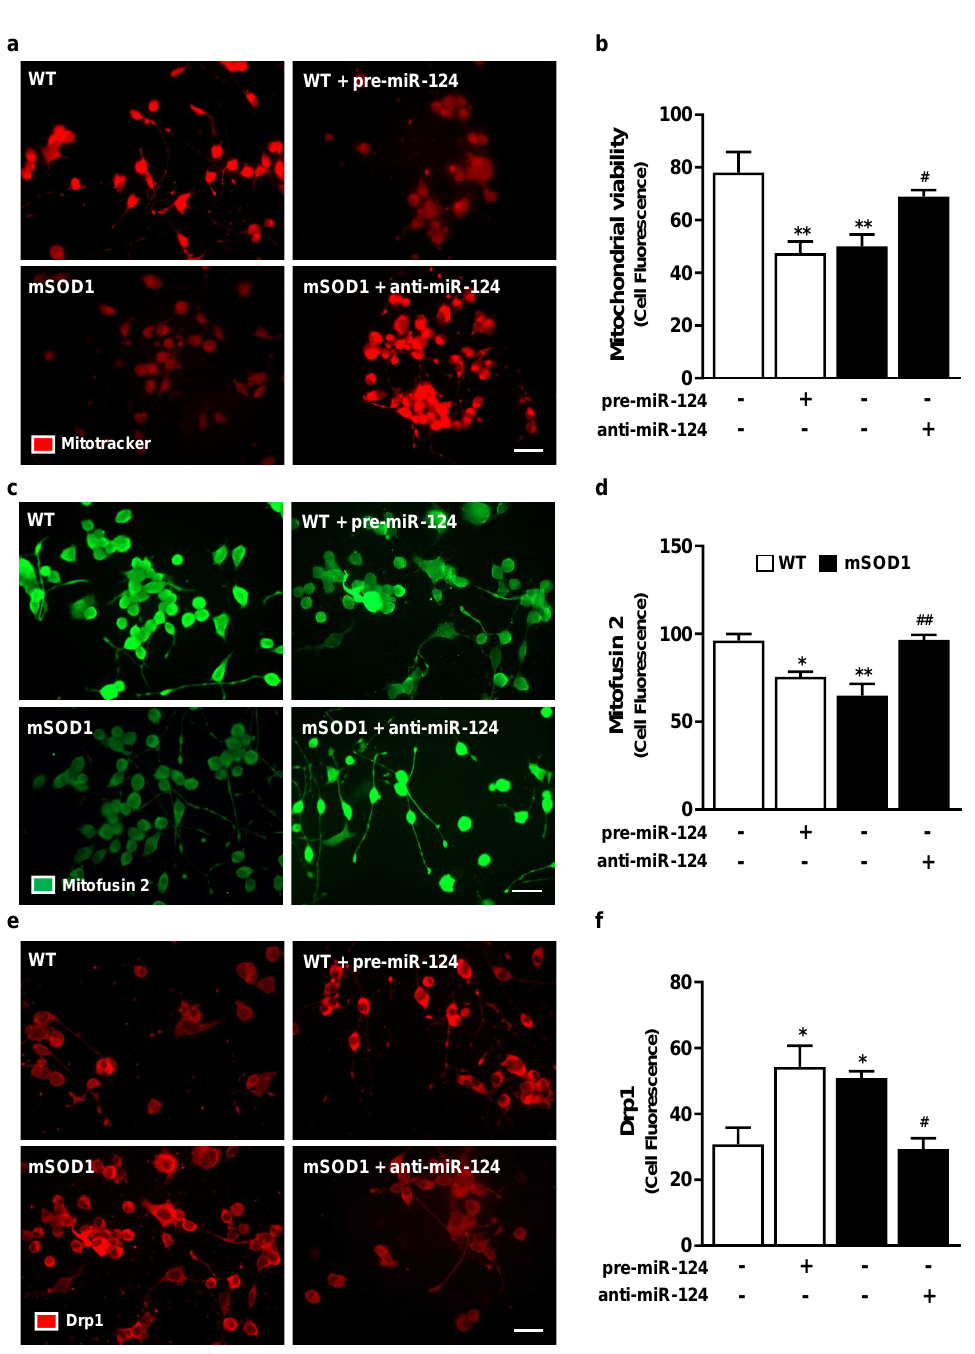
Figure 4. Compromised mitochondrial viability, fusion, and fission in MNs with high levels of miR-124 is prevented by anti-miR-124 transfection in mSOD1 MNs. After 2 days of differentiation, NSC-34 (wild type, WT) MNs and mSOD1 MNs were transfected with pre-miR-124 or anti-miR-124, respectively, for 12 h and maintained for additional 48 h. ( a , b ) Mitochondrial viability was measured by using MitoTracker™ Red staining. Protein levels of ( c , d ) mitofusin 2 (in green) and ( e , f ) DRP1 (in red) were evaluated by immunocytochemistry using specific antibodies. ( a , c , e ) Representative images are shown. Quantification of total fluorescence indicated in plots ( b , d ) and ( f ) was done in Image J software and normalized to the total cell number. Results are mean ± SEM from at least 4 independent experiments. ** p < 0.01, * p < 0.05 vs. WT MNs; ## p < 0.01, # p < 0.05 vs. mSOD1 MNs; one-way ANOVA followed by multiple comparisons Bonferroni post-hoc correction. Scale bar: 20 µ m. Drp1, dynamin related protein 1; MNs, motor neurons; mSOD1, MNs overexpressing G93A mutation in superoxide dismutase 1; WT, wild